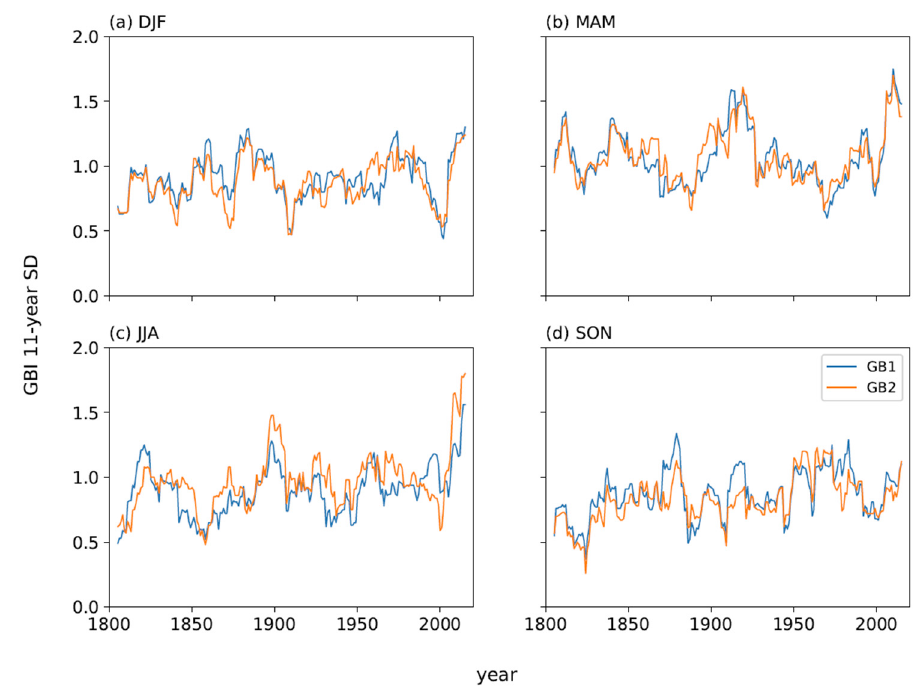
Figure 5. Smoothed seasonal series of GB 1 and GB 2 for ( a ) winter (DJF), ( b ) spring (MAM), ( c ) sum- mer (JJA) and ( d ) autumn (SON). GBI yearly values have here been filtered using a 21-point bino- mial filter to emphasize any long-term fluctuations and trends.